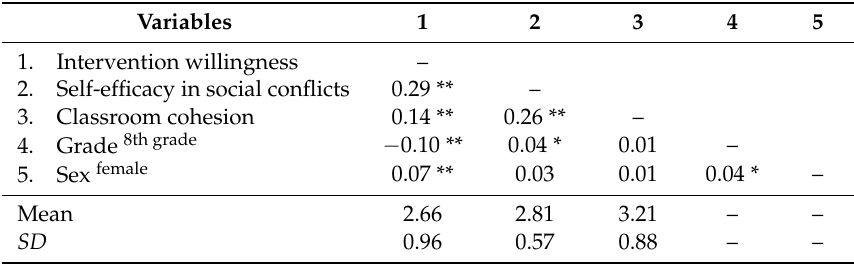
Table 2. Bivariate correlations between classroom cohesion, self-efficacy, intervention willingness, and control variables, means, and standard